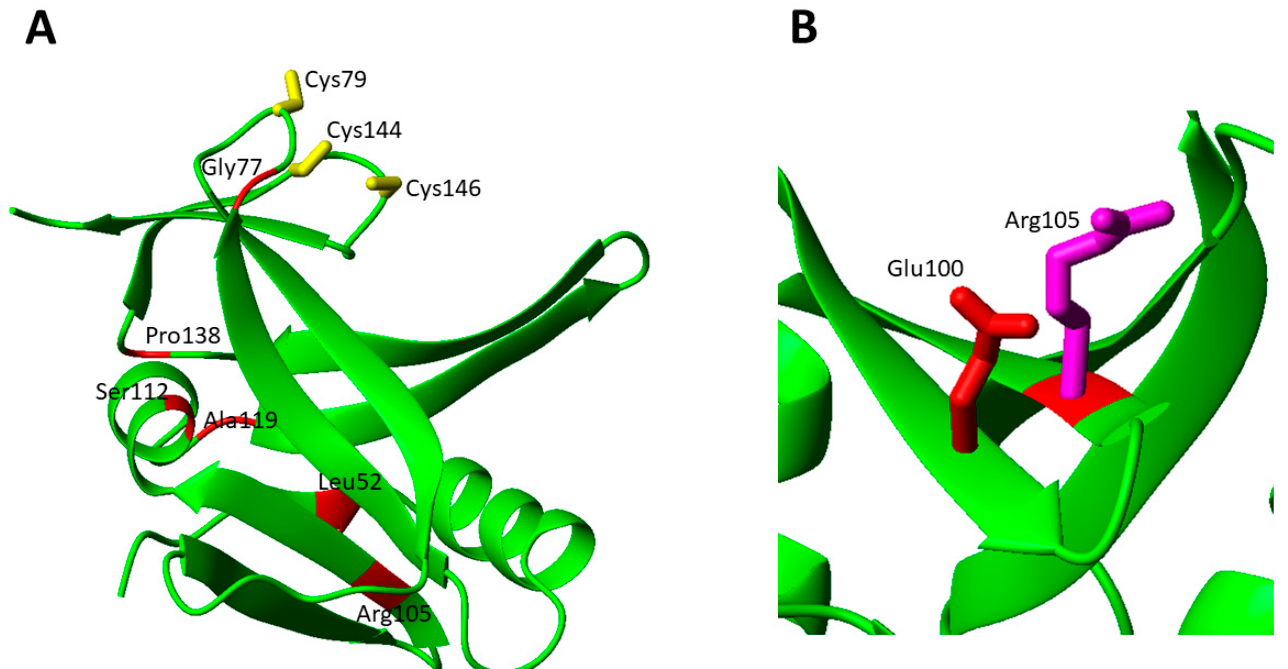
Figure 7. Pathogenic missense mutations mapped on the structural model of human ISCA2 obtained by AlphaFold2. ( A ) The backbone of the residues involved in pathogenic missense mutations of ISCA2 is colored in red on the ribbon structure of monomeric apo ISCA2, and the sidechains of the three conserved cluster coordinating Cys residues are shown in yellow. ( B ) The electrostatic interaction established between the negatively charged carboxylate of the sidechain of Glu100 (in red) and the positively charged guanidinium group of the sidechain of Arg105 (in magenta) is shown. Leu52Phe was found in homozygosity in one patient, showing a mild phenotype, The Gly77Ser mutation (c.G229 > A) was found in homozygosity in 20 cases from 18 different families [81–83]. In all patients after a normal initial development, a